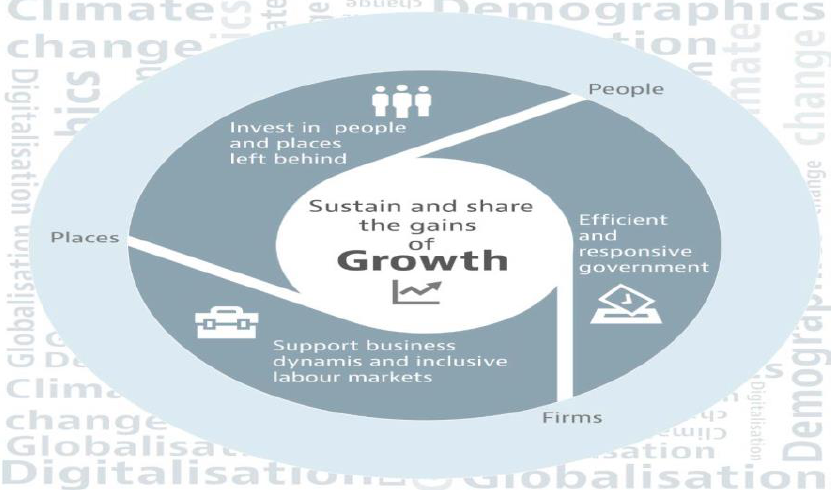
Figure 1: The Framework for Policy Action on Inclusive Growth; Source: OECD Policy brief